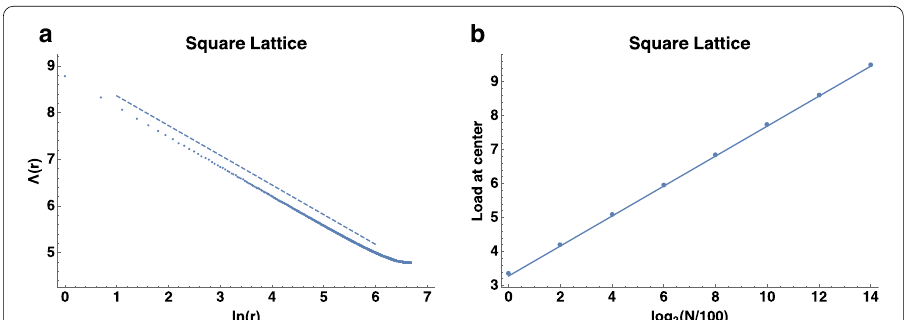
Fig. 1 a Load as a function of the logarithm of the distance r from the center of a square lattice. Demand is only broadcast from the center, uniformly to all other nodes. For definiteness, the load is shown for nodes 1600 2 . The dashed line has a slope of 2 /π . b Load at the center as a along the x axis, for a lattice with N = − function of N , the number of nodes in the square lattice, when demand is broadcast from the center equally to all nodes. The ( 2 /π) ln N dependence is in agreement with the analytical